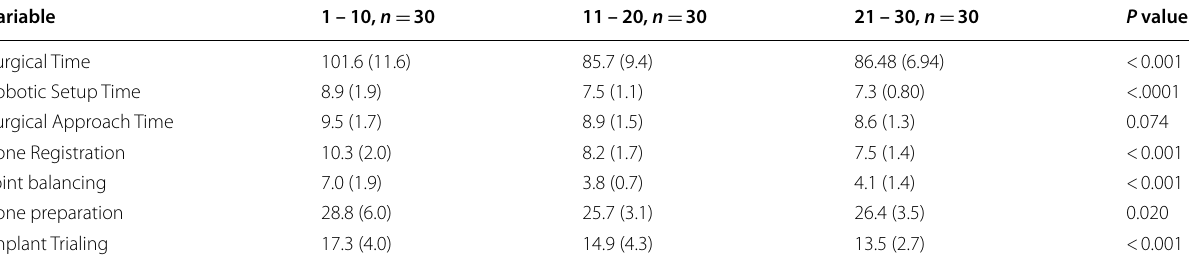
Table 4 Comparisons of operating room times (minutes) between raTKA groups of ten, all three surgeon’s cases combined, reported as mean (SD)